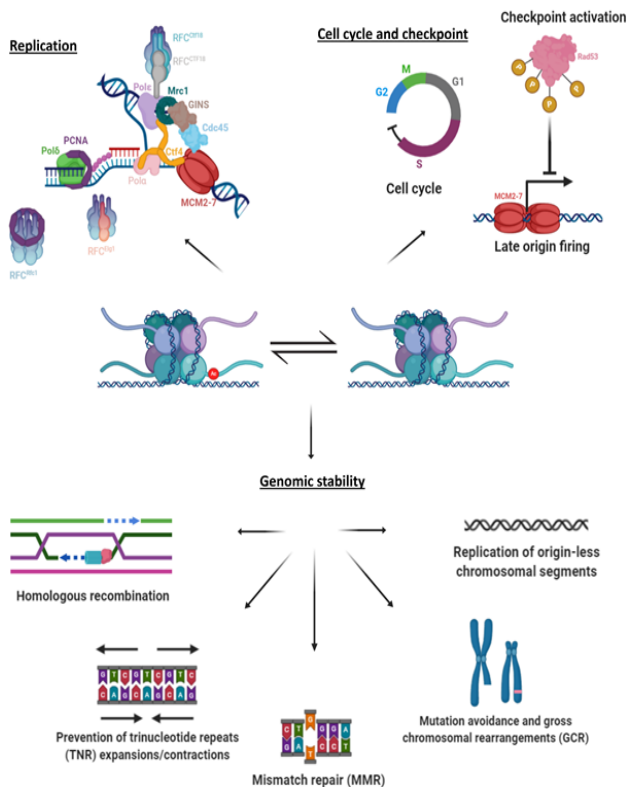
Figure 2. A summary of the different roles of H3K56Ac: H3K56Ac has been implicated in a variety of processes, related both to replication and to genome stability. Of these processes, evidence exists that ties H3K56Ac to homologous recombination repair pathways, in particular strand invasion and break induced repair (BIR). In addition, there is an effect on mismatch repair, expansions and contractions in the number of trinucleotide repeats, maintenance of origin-less chromosomal segments, and the prevention of chromosomal abnormalities such as mutations and rearrangements. H3K56Ac is also connected to replication, and to firing of origins and cell cycle progression. See text for more